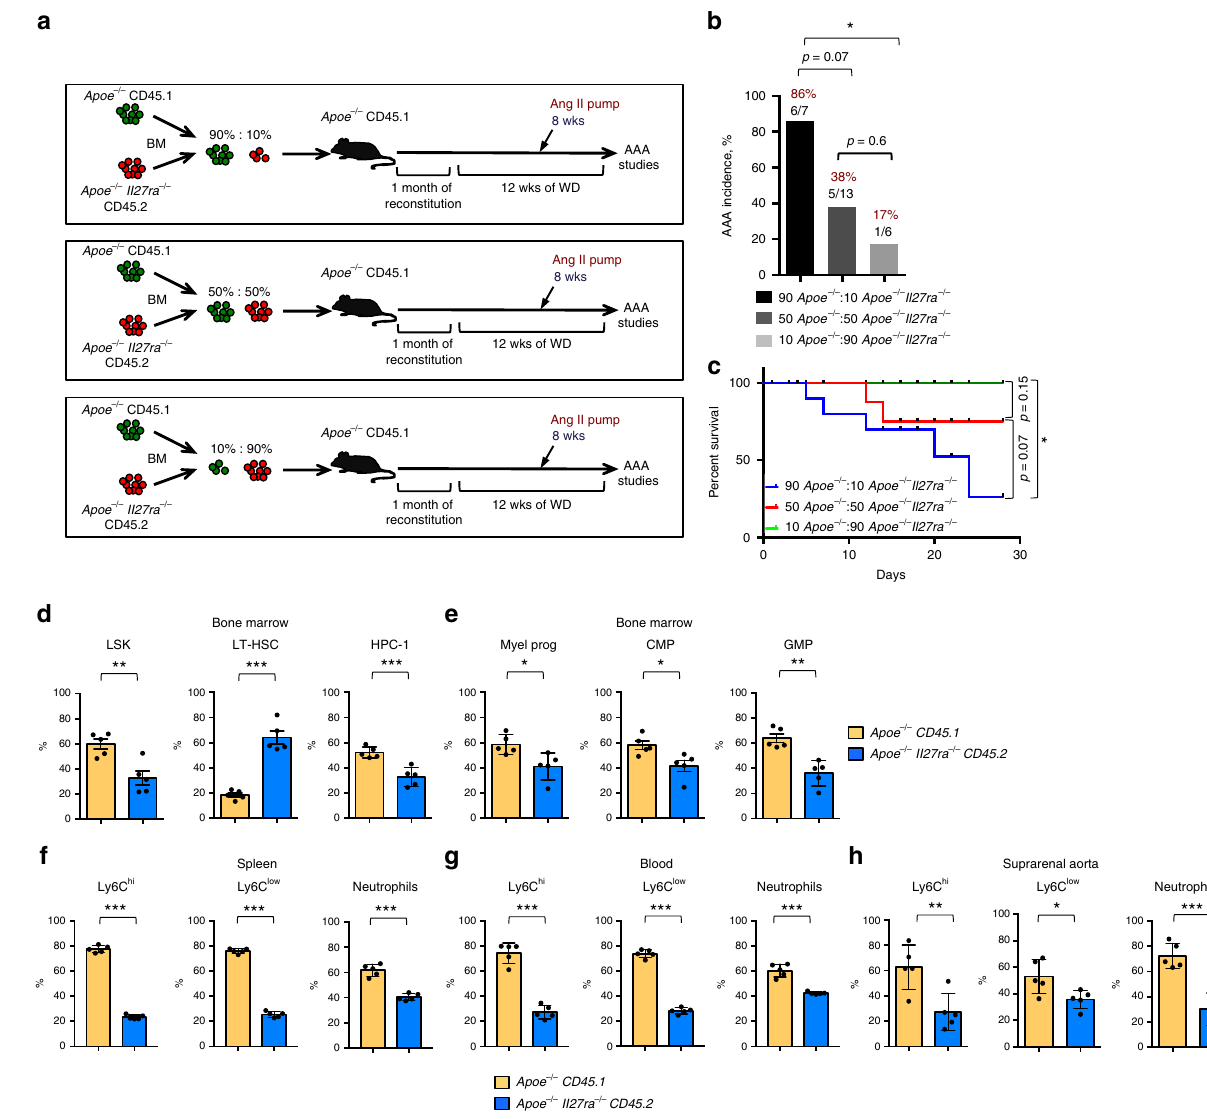
Fig. 5 IL-27R de fi cient HSCs fail to induce AAA. a Scheme of experiment. Apoe − / − CD45.1-recipient mice were lethally irradiated and reconstituted with donor mixes of Apoe − / − CD45.1 and Apoe − / − Il27ra − / − CD45.2 total BM cells in a 90%:10%, 50%:50%, and 10%:90% ratio, respectively. Four weeks after reconstitution mice were placed on WD for 12 weeks and infused with Ang II for last 4 weeks of feeding. b Percentage of AAA incidence among Apoe − / − CD45.1-recipient mice receiving BM mixture in a ratio: 90% Apoe − / − : 10% Apoe − / − Il27ra − / − ( n = 7), 50% Apoe − / − : 50% Apoe − / − Il27ra − / − ( n = 13), or 10% Apoe − / − : 90% Apoe − / − Il27ra − / − ( n = 6). * p < 0.05, Fisher ’ s exact test (two-sided). c Survival curves for Apoe − / − CD45.1-recipient